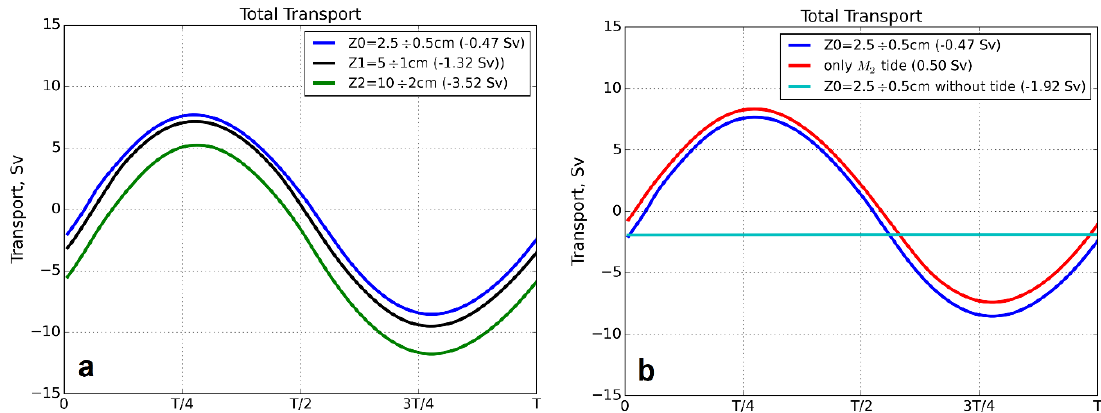
Figure 5. ( a ) transport through the strait under variants of boundary conditions on the northern boundary for the one tidal period of the M 2 wave (T = 12.42 h). ( b ) tide contribution to transport through the strait.